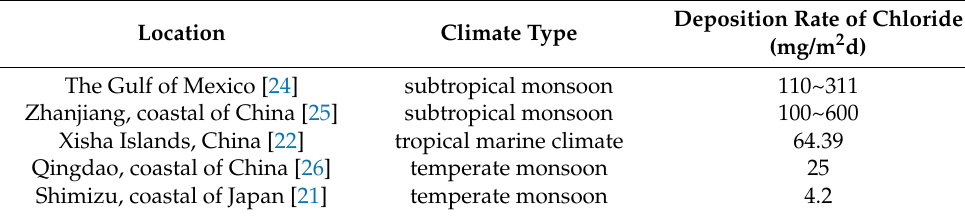
Table 4. The deposition rate of chloride in static marine atmospheric exposure